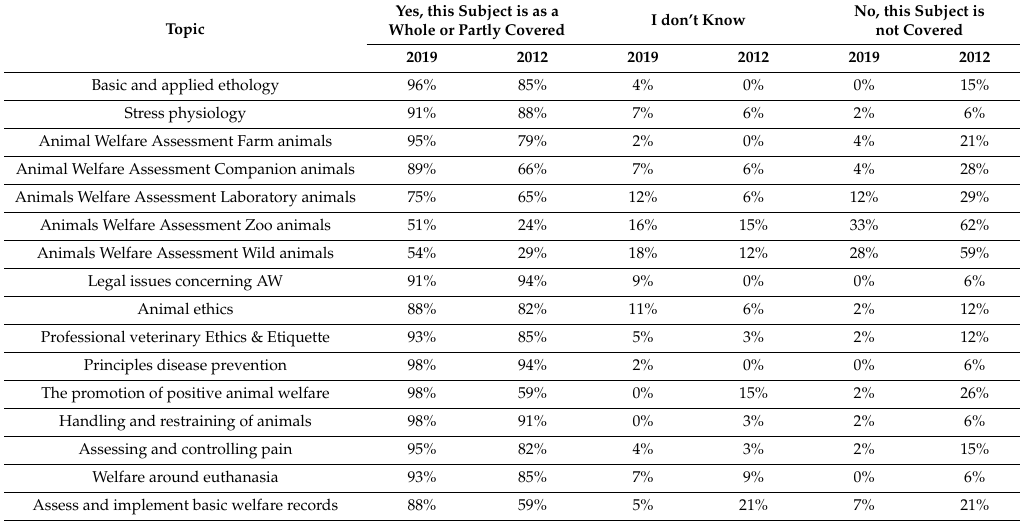
Table 3. Teaching of specific animal welfare